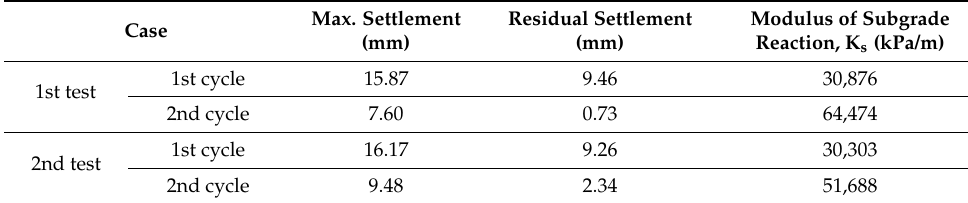
Figure 11. Load-settlement curve of repetitive loading test. Table 6. Test result of repetitive loading